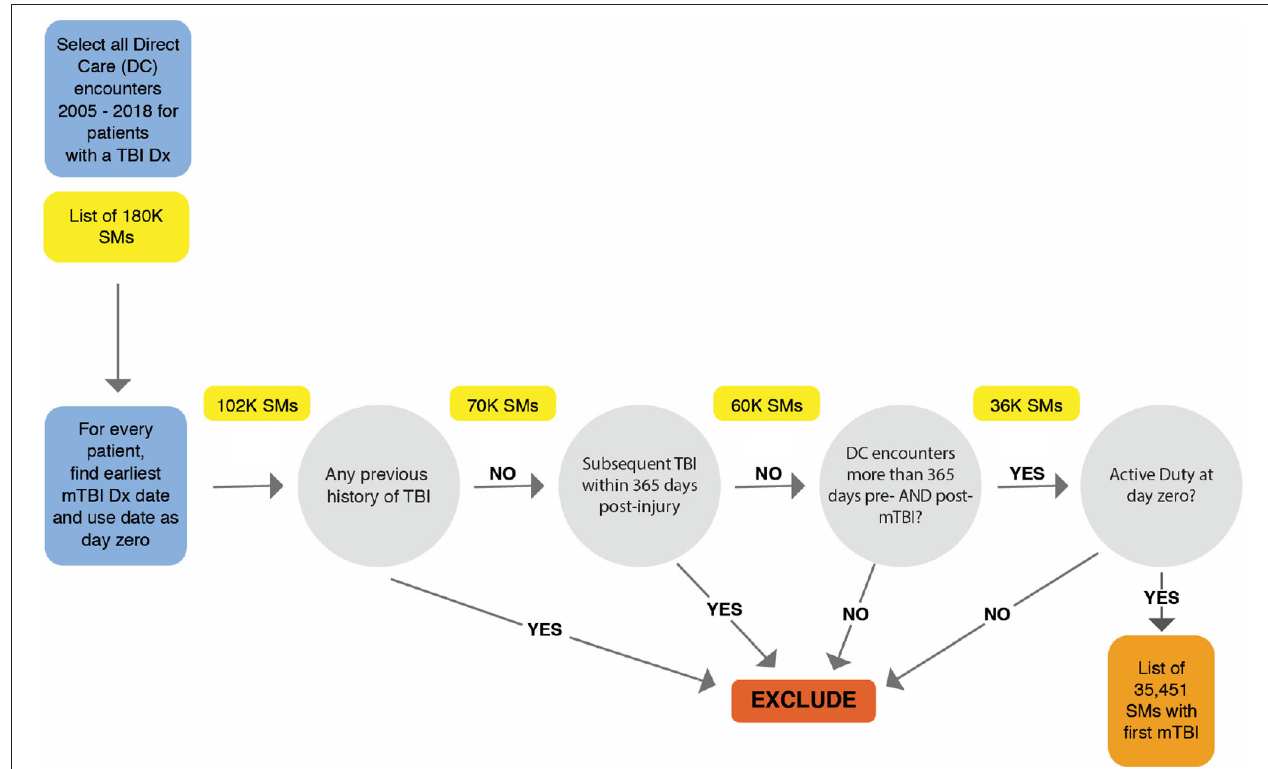
FIGURE 1 | Methodology for selecting sample